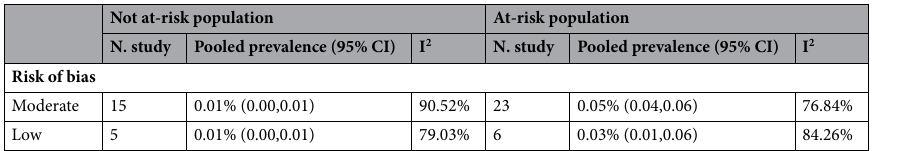
Table 6. Pooled prevalence of CD according to risk of bias.